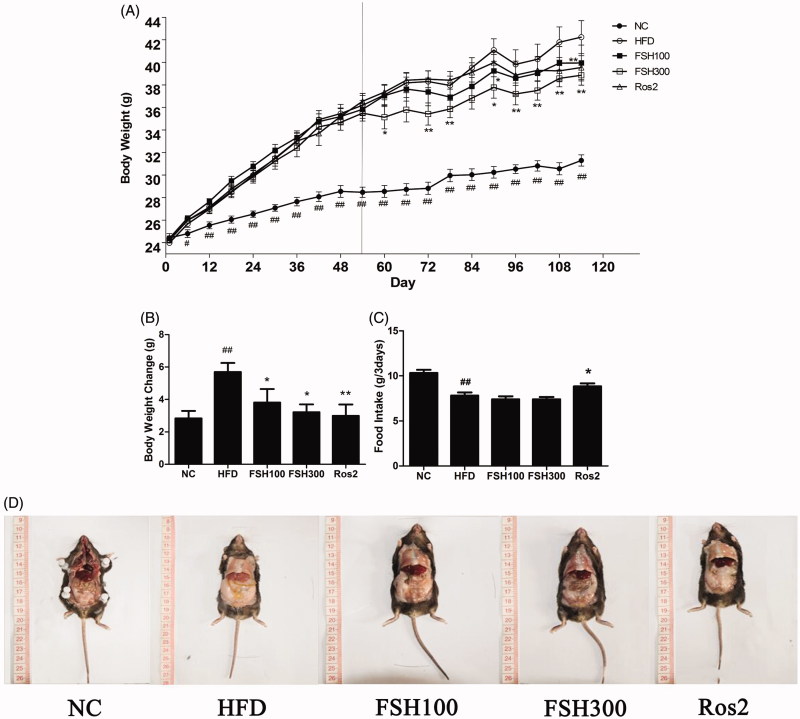
Effect of FSH on body weight and food intake in HFD-induced obese mice. (A) Body weight during the experiment. (B) Change of body weight between the 9th week and 17th week. (C) Average food intake per mouse was recorded at an interval of 3 d. (D) Abdominal adipose tissue. Values are expressed as mean ± S.E.M (n = 10). *p < 0.05, **p < 0.01, vs. the HFD group, respectively; ##p < 0.01, vs. the NC group.